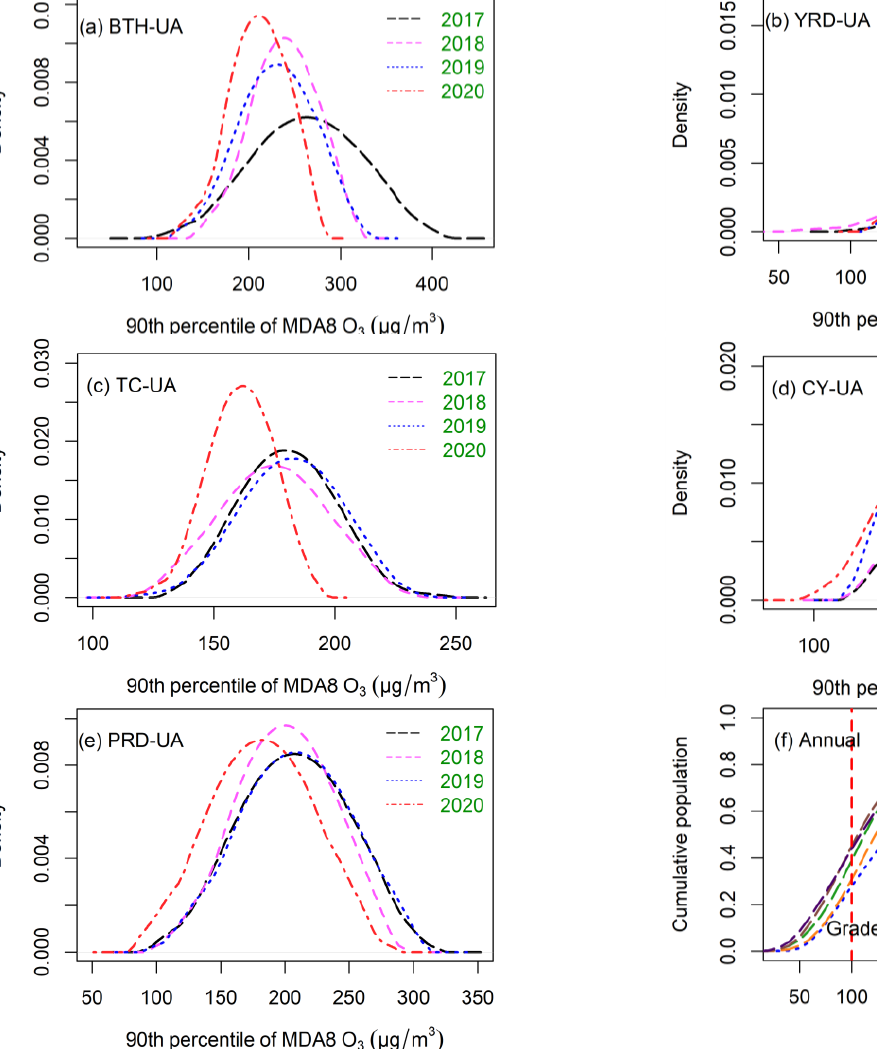
Figure 2. Kernel-density estimates of annual mean O 3 concentrations in ( a ) BTH-UA, ( b ) YRD-UA, ( c ) TC-UA, ( d ) CY-UA, and ( e ) PRD-UA. ( f ) The annual over-standard rate of the O 3 concentrations